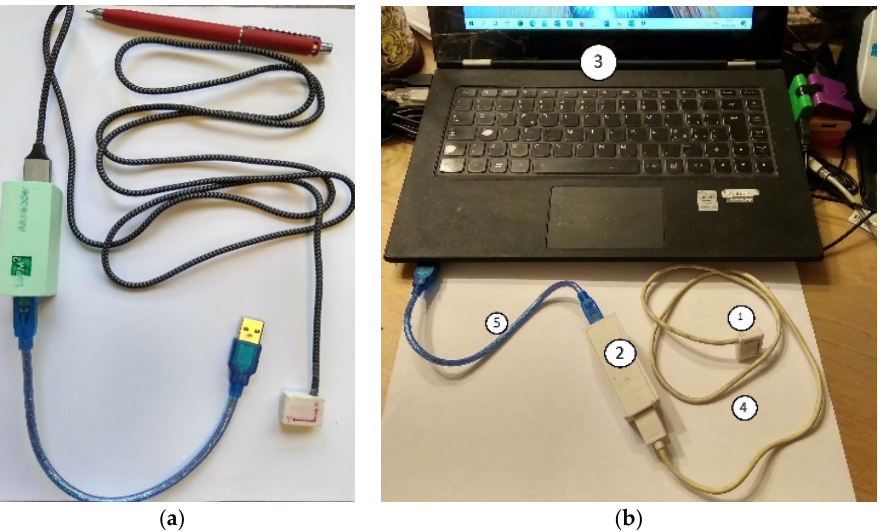
Figure 2. A built prototype of a SENSIRIB device: ( a ) the portable mechanical design; ( b ) the connection to a laptop.